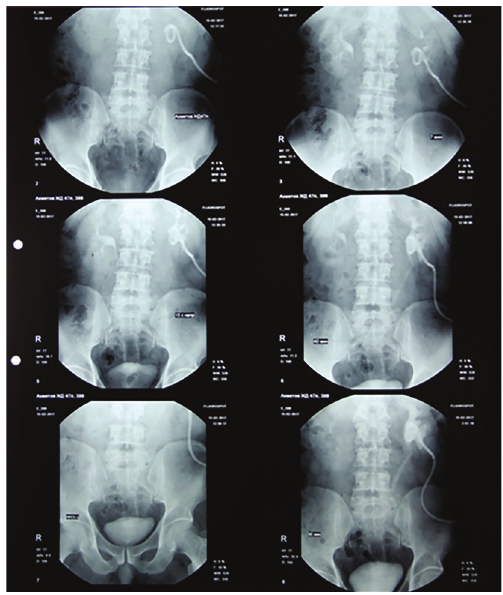
Figure 10 - Extracorporal preparation of kidney